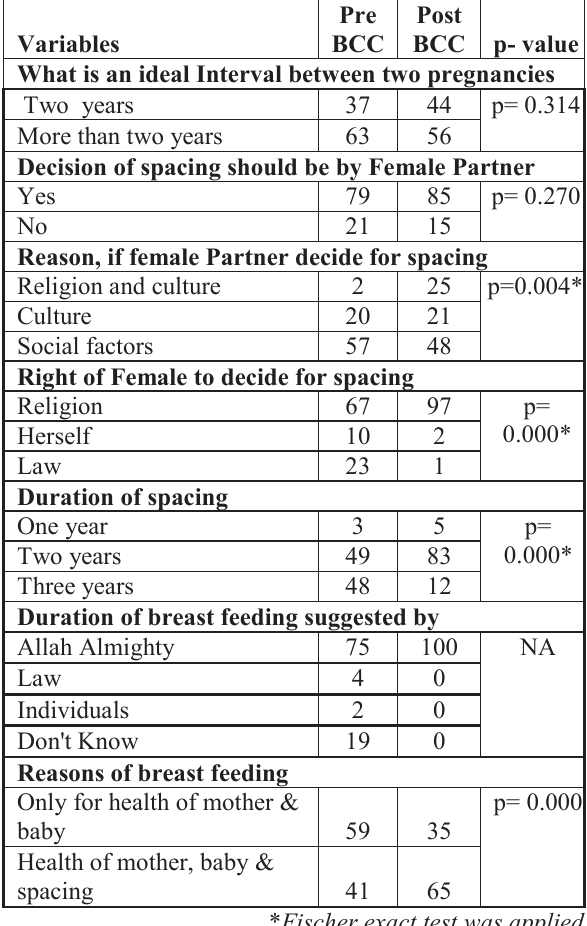
Table-2: Change in knowledge regarding